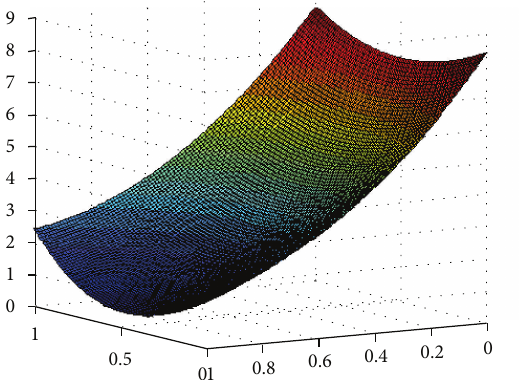
𝑥𝑦𝑧 Figure 11: Geometrical model of a single reflector with its observa- tion surface.